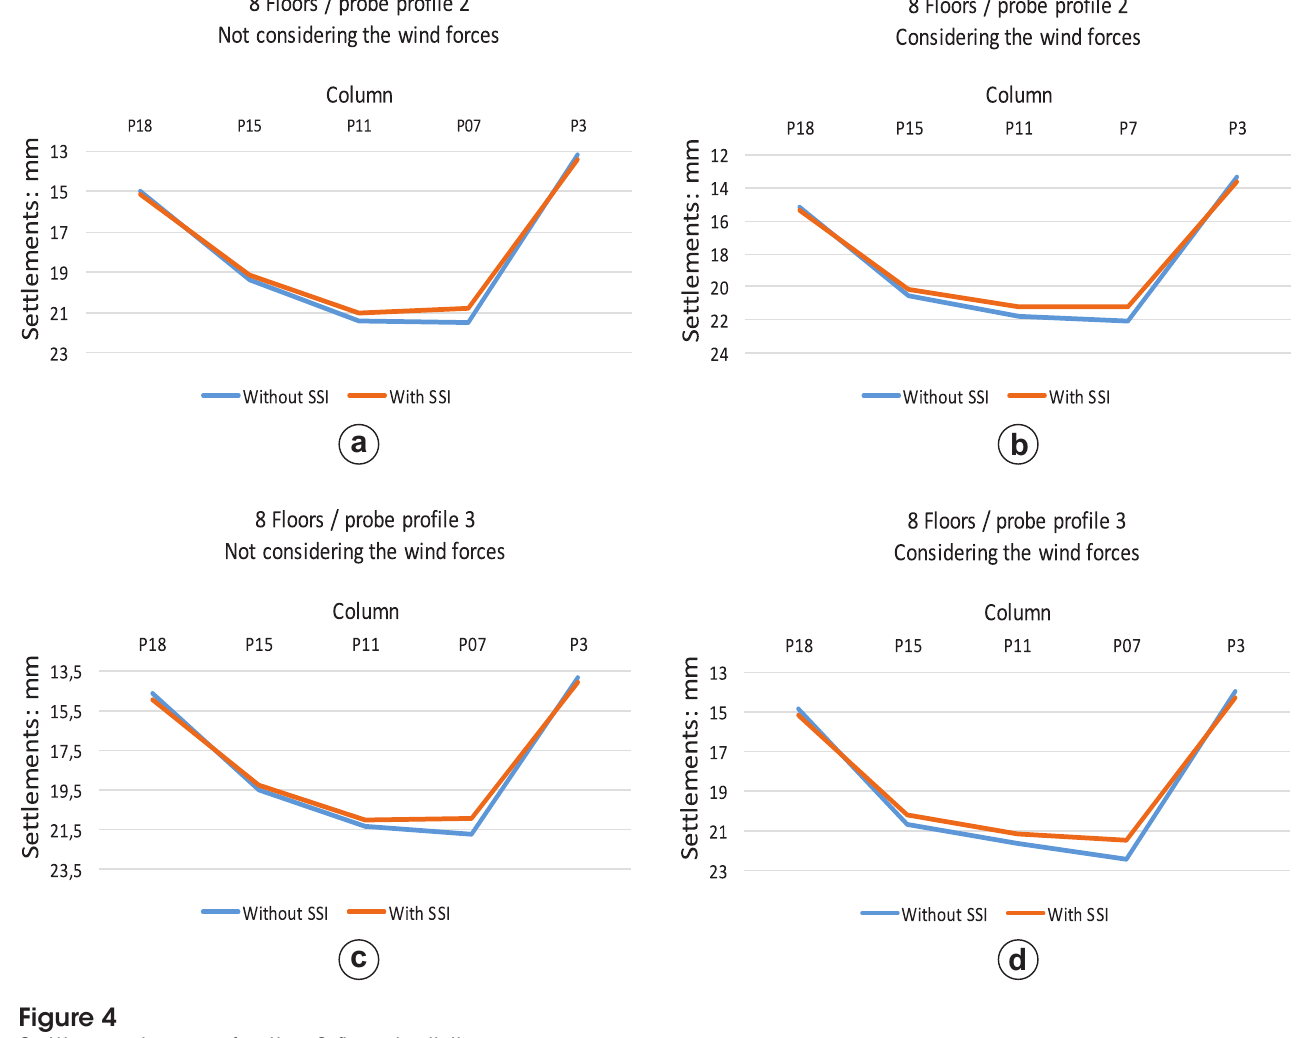
Settlement curve for the 8-floor building